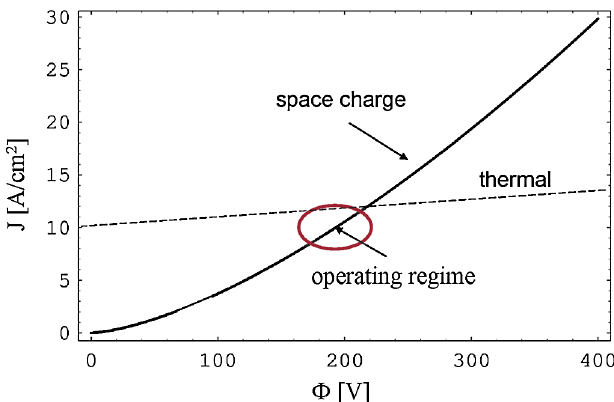
FIG. 3. Current density-voltage characteristics, J vs (cid:2) . The solid curve is the space-charge limit (Child-Langmuir) and the dashed curve is the thermal limit (Richardson-Dushman- FIG. 4. Schematic of grid wires used for obtaining an estimate Schottky). The characteristics are for the case with gap spacing d ¼ 250 (cid:3) m , work function (cid:2) ¼ 1 : 9 eV , and cathode tem- of the beam emittance due to the grid. The rings comprising the WF perature T c ¼ 1300 K . The optimum operating region is near the grid in Fig. 2 are modeled by an array of parallel grid wires. The intersection of the two limits where the current density is not a grid wires, with radius r o , are at a potential (cid:2) G , are parallel to the y axis, separated by a distance 2 a , and located at z ¼ z G . sensitive function of the cathode temperature.